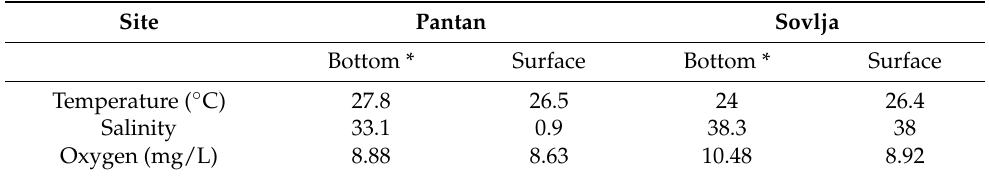
Table 1. Summary of hydrographic characteristic during collecting juveniles of Diplodus puntazzo and Diplodus vulgaris at sampling sites (June 2018). Site Pantan Sovlja Bottom * Surface Bottom * Surface Temperature ( ◦